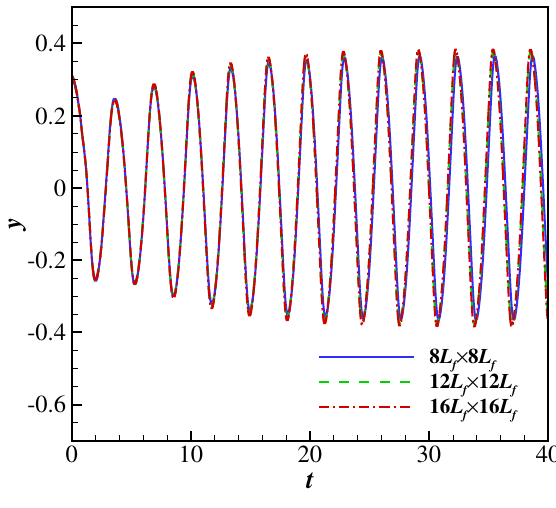
Figure 4. A 2D filament flapping in a Newtonian uniform flow: The time history of the transverse displacement of the trailing edge node at Re = 200 in domains with different sizes (8 L f × 8 L f , 12 L f × 12 L f and 16 L f × 16 L f